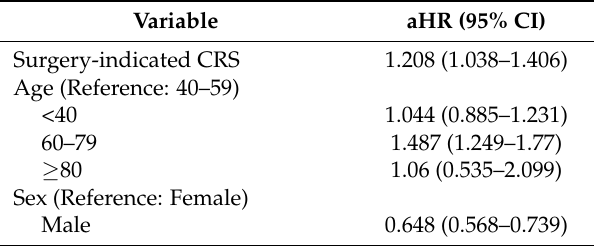
Table 3. Multiple Cox proportional hazard regression for the estimation of adjusted hazard ratios on keratopathy.